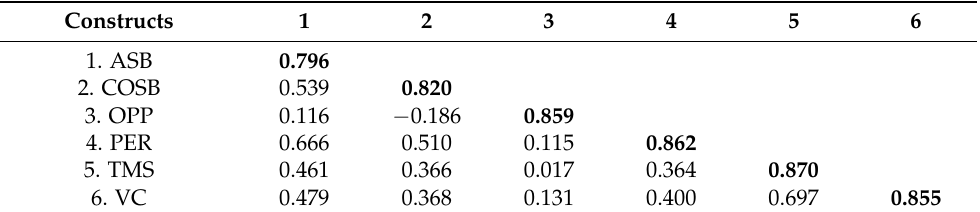
Table 4. Correlation matrix and squared roots of AVE in